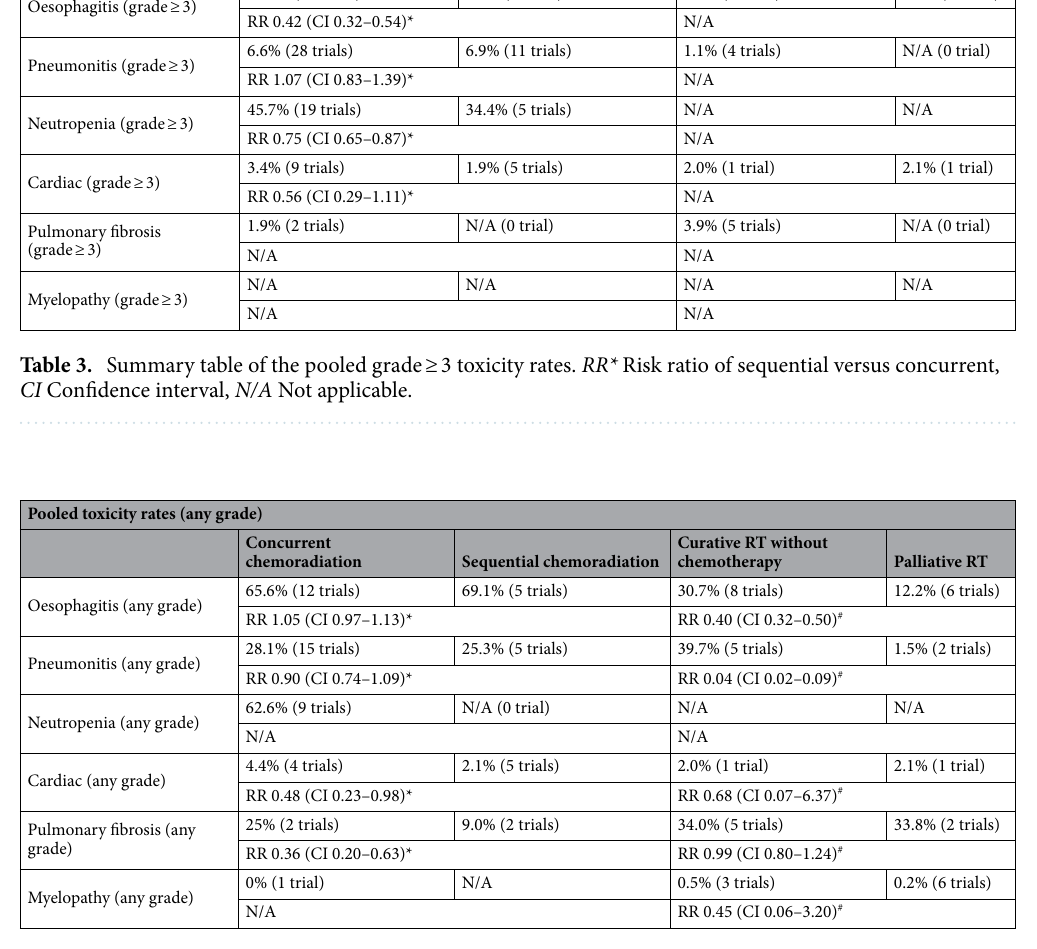
Table 4. Summary table of the pooled any grade toxicity rates. RR* Risk ratio of sequential versus concurrent, RR # Risk ratio of palliative versus curative radiation therapy alone, CI Confidence interval, N/A Not applicable.